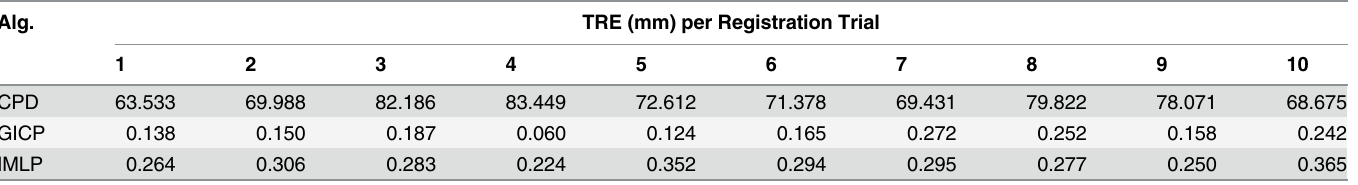
Target registration error (TRE) is reported for each of 10 registration trials conducted for Experiment 7, which involve registering two half-sections of the statue Laurana that have 50% true overlap (Fig. 9D). The half-sections were randomly misaligned by 10 mm and 10 degrees and then registered using CPD [20], GICP [11], and the proposed IMLP